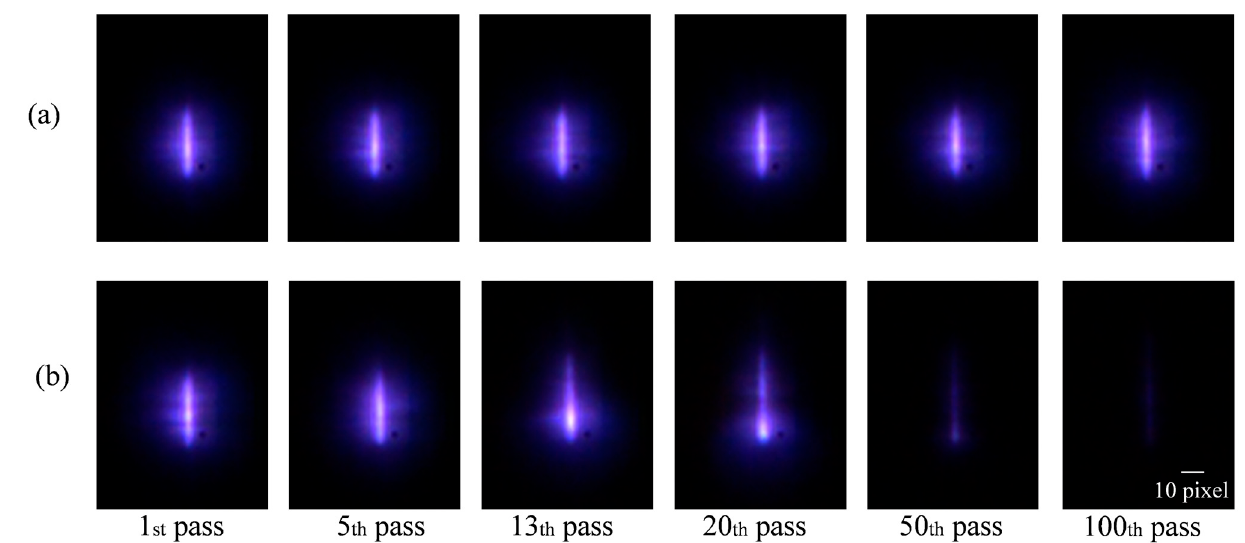
Figure 4. Evolution of typical plasma images for ( a ) first pass; and ( b ) changes with processing pass for PLG at a pulse pitch of 2 μ m.